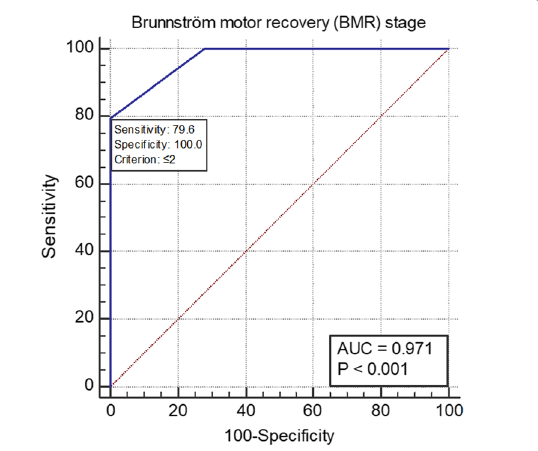
Fig. 6 Disease duration (months)